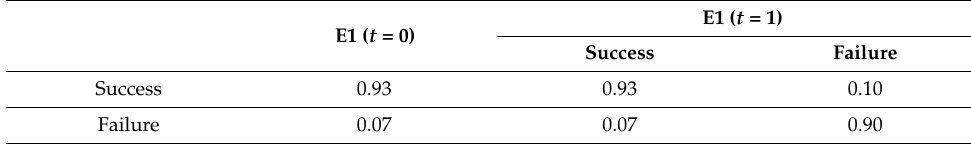
Table 3. The prior probabilities of the